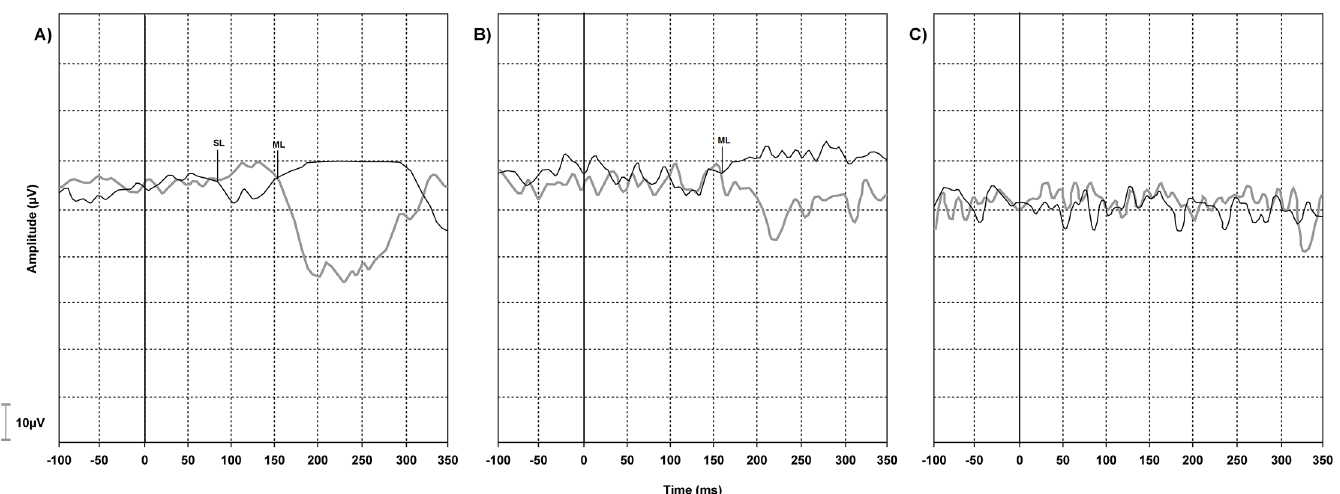
Fig 5. Vestibular-evoked myogenic potential triggered by galvanic vestibular stimulation (galvanic-VEMP) tracings. (A) Delayed short-latency (SL) and medium- latency (ML) waves in an individual with asymptomatic human T-cell lymphotropic virus type 1 (HTLV-1) infection. (B) Absent SL response with delayed ML response latency in an individual with possible HTLV-1-associated myelopathy (HAM). (C) Absent SL and ML responses in an individual with HAM. These recordings were obtained from subjects with their heads rotated to the left and electromyographic (EMG) responses recorded from the right gastrocnemius muscle. The black line indicates the trace recorded with the cathode and anode on the right and left side respectively, whereas the gray line indicates the opposite stimulation polarity. SL, short-latency response onset; ML, medium-latency response onset. https://doi.org/10.1371/journal.pone.0200536.g005 PLOS ONE | https://doi.org/10.1371/journal.pone.0200536 July 12,